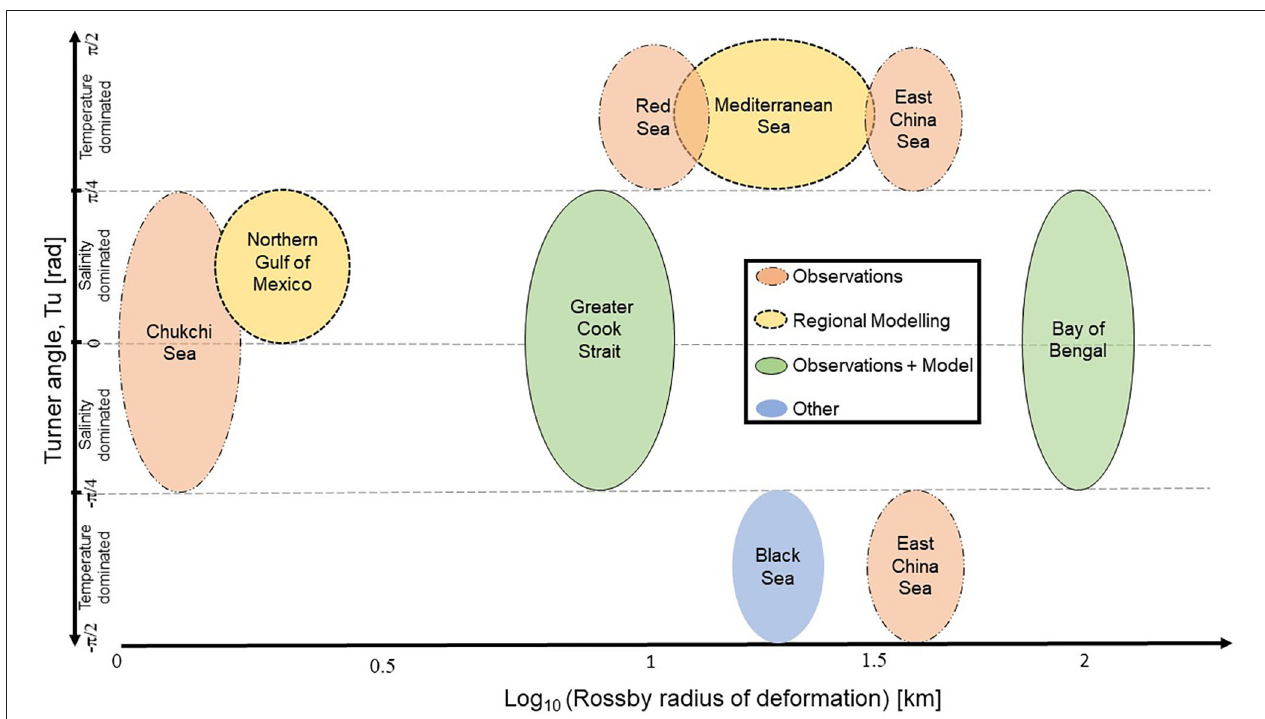
FIGURE 12 | Oceanic regions influenced by salinity gradients, placed on the Turner angle range and respective Rossby radius of deformation. Influence on oceanic regions inferred from Timmermans and Winsor (2013) (Chukchi Sea); Barkan et al. (2017a) (Northern Gulf of Mexico); Jhugroo et al. (2020) (Greater Cook Strait—this study); Jaeger and Mahadevan (2018) (Bay of Bengal); Shi and Wei (2007) (East China Sea); Meccia et al. (2016) (Mediterranean Sea); You (2002) (Red Sea); and Kelley et al. (2003) (Black